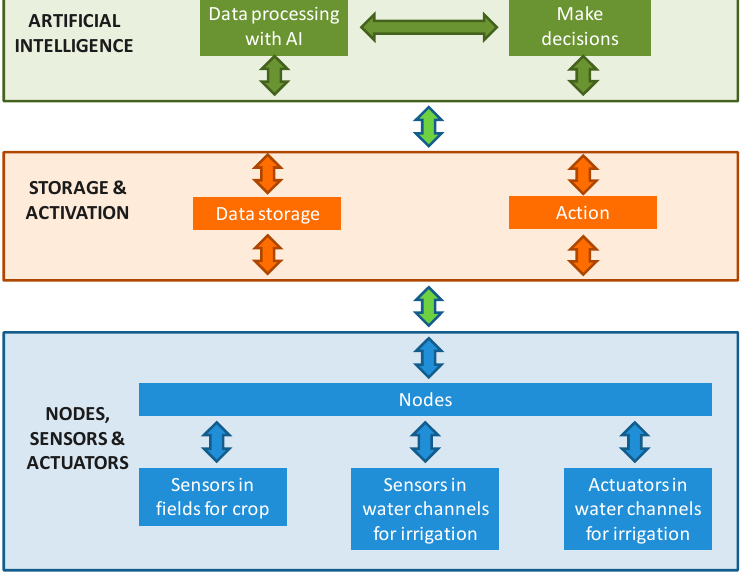
Figure 3. Proposed architecture.